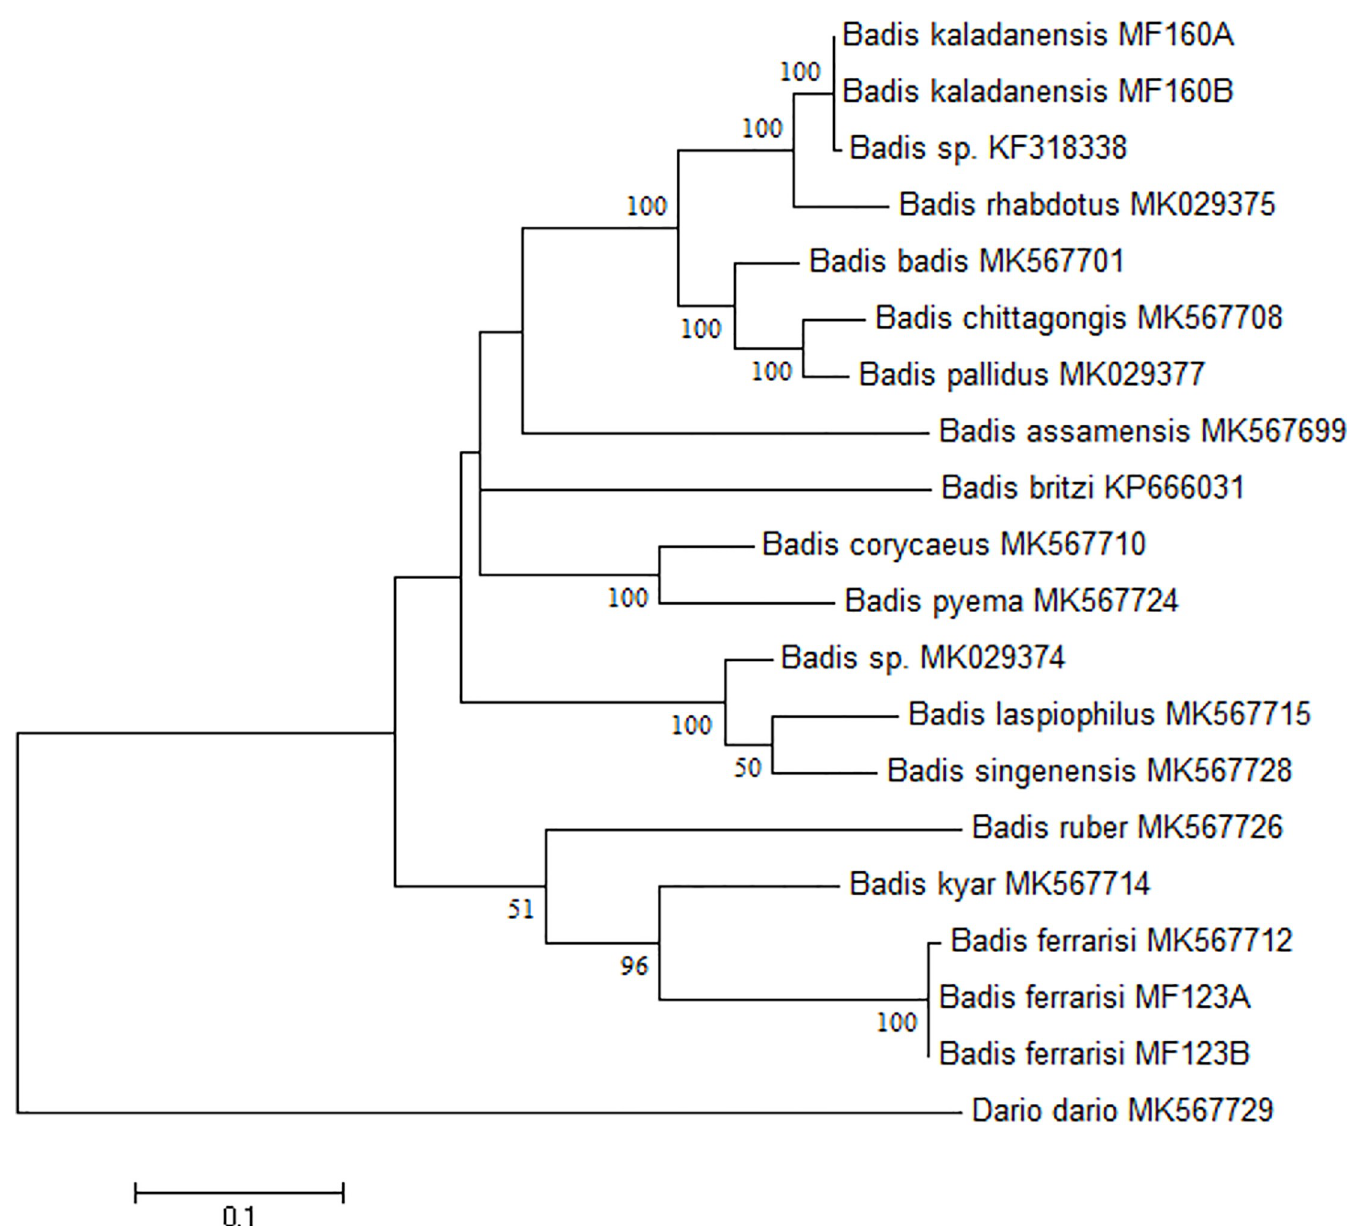
Fig 1. Maximum Likelihood (ML) tree of coi dataset of 32 sequences using HKY+G+I nucleotide substitution model with 1000 bootstraps. Holotype. ZSI FF 5404, 48.6 mm SL; India; Mizoram, Palak river in the vicinity of Phurra Village; 22˚14’12"N; 92˚53’59"E; Lalronunga et al ., 15 Nov. 2012. Paratypes. ZSI FF 5404 (2), 40.1–49.3 mm SL; data same as holotype. PUCMF 15001 (4), 28.2–44.8 mm SL; same data as holotype. PUCMF 15002 (5), 32.2–46.7 mm SL; India; Mizo- ram, Palak river in the vicinity of Palak Lake; 22˚12’18"N; 92˚53’33"E; Vanlalmalsawma & Lal- ramliana, 7 Dec. 2011. PUCMF 15003 (3), 35.3–47.5 mm SL; India; Mizoram, Sala river in the vicinity of Lungpuk Village 22˚04’05"N 92˚55’19"E; Lalronunga et al ., 14 Nov. 2012. PUCMF 15004 (4), 30.2–42.7 mm SL (cleared and stained); data same as holotype.